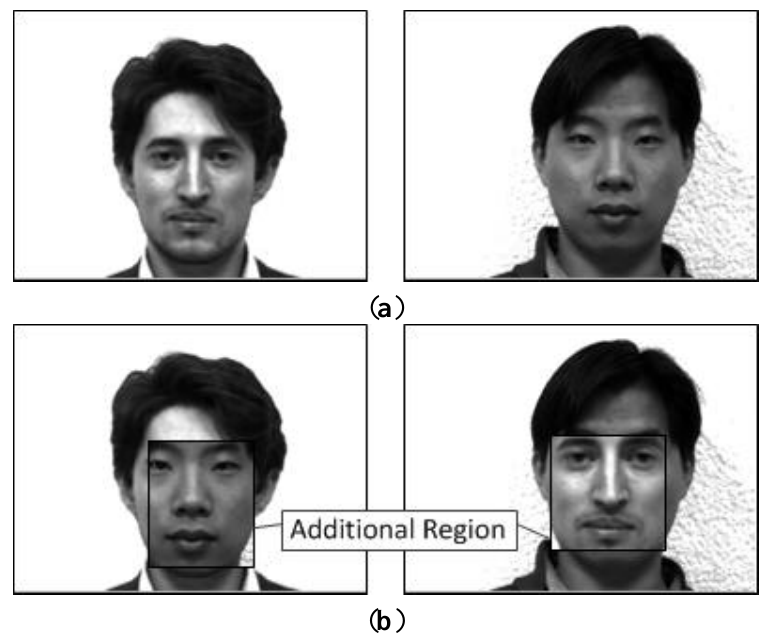
Figure 1. Face images for Chen’s experiments: ( a ) Normal faces; ( b ) Mixed